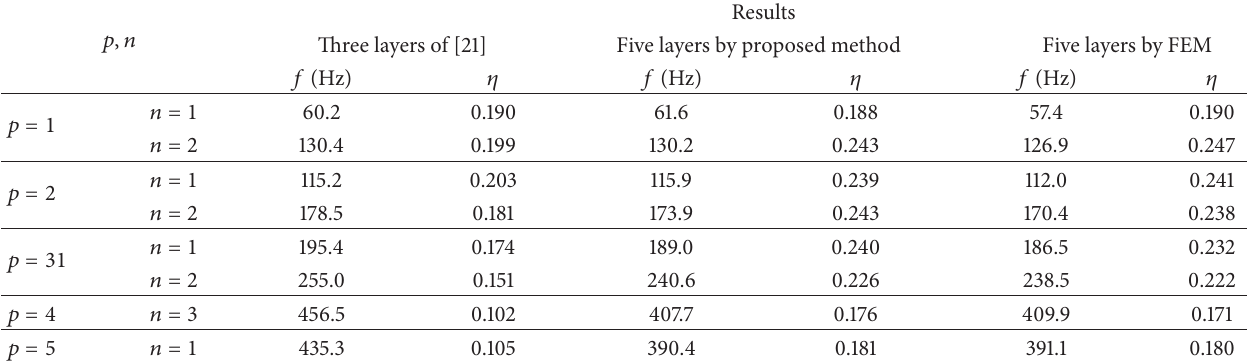
Table 1: Dynamical results of three- and five-layered constrained damping